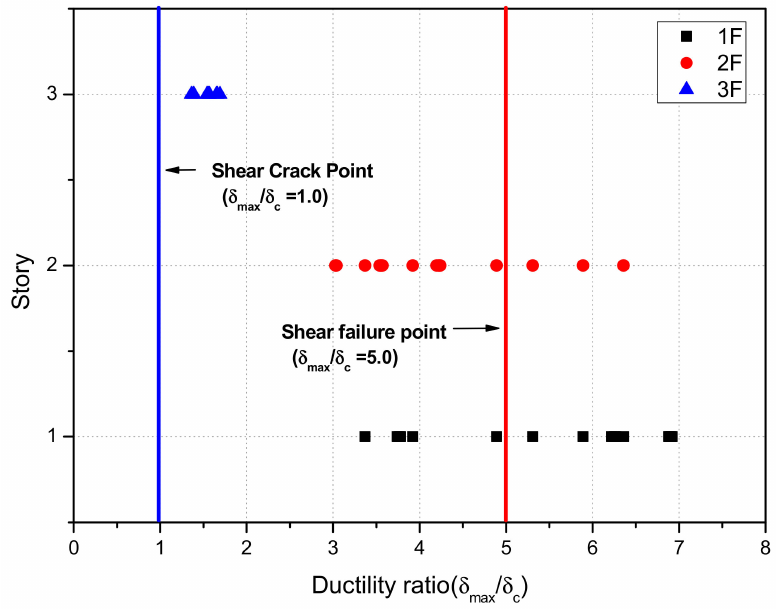
Figure 32. Shear ductility of all column members determined via nonlinear dynamic analysis of the reference